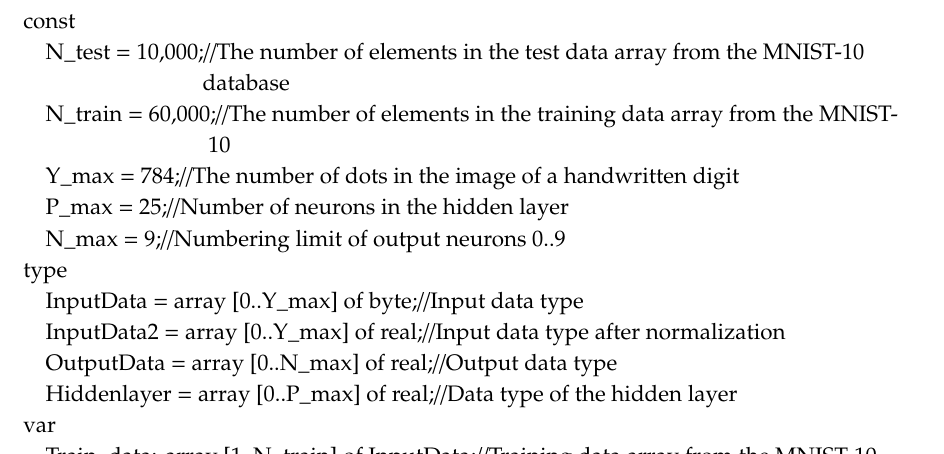
Algorithm A1. Initialization of basic constants, types, arrays, variables and functions. const